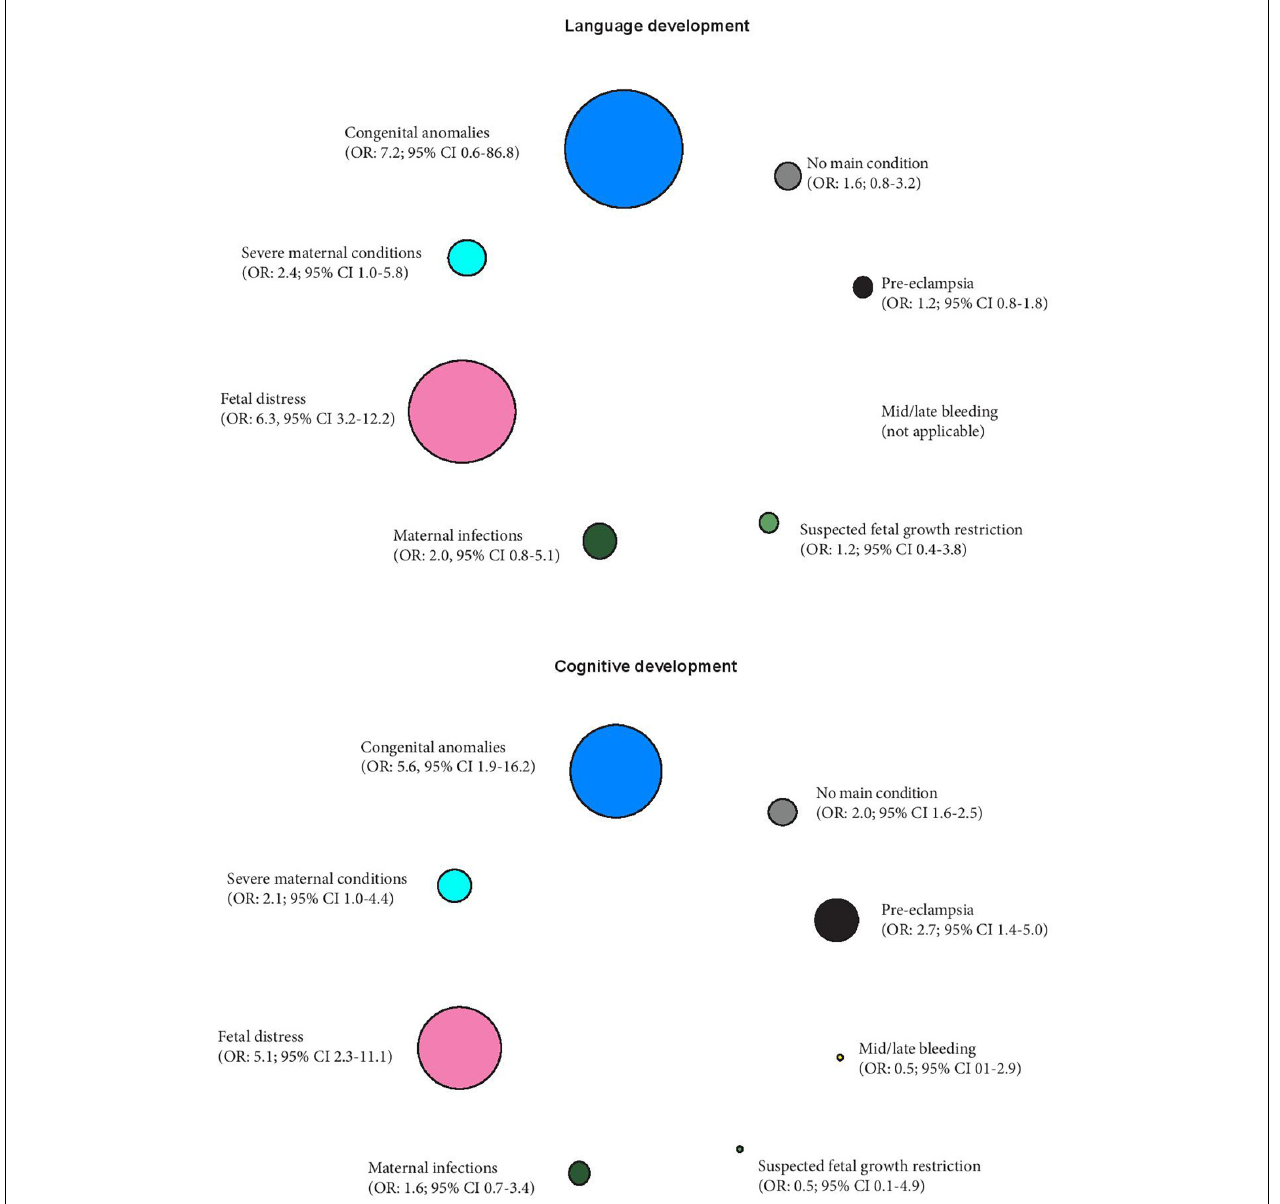
FIGURE 2 | Preterm phenotypes and the association with early childhood language and cognitive development expressed as odds ratios (OR) and 95% confidence intervals, using term newborns as the reference group (Villar et al., 2021b). The different sizes of the circles represent the strength of the